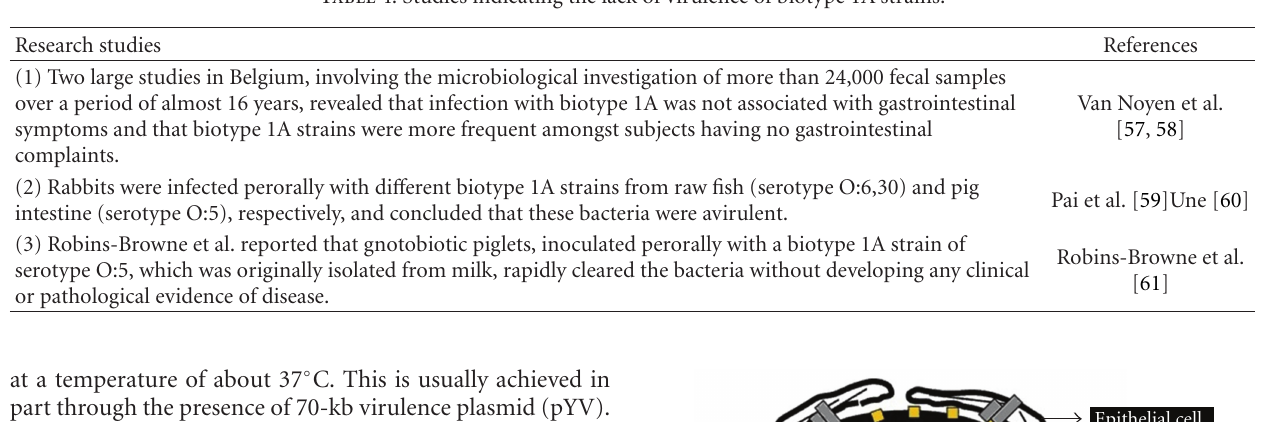
Table 4: Studies indicating the lack of virulence of biotype 1A strains.